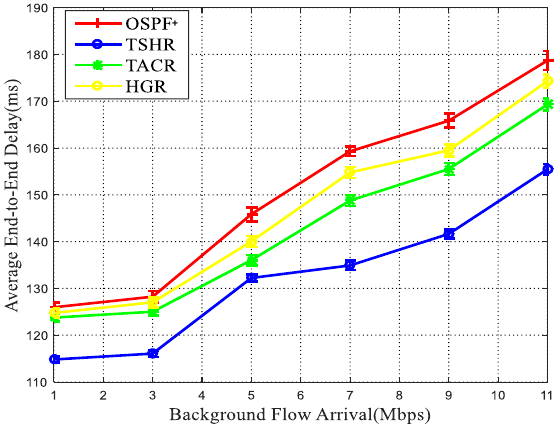
Figure 11. Delay vs. background flow arrival.